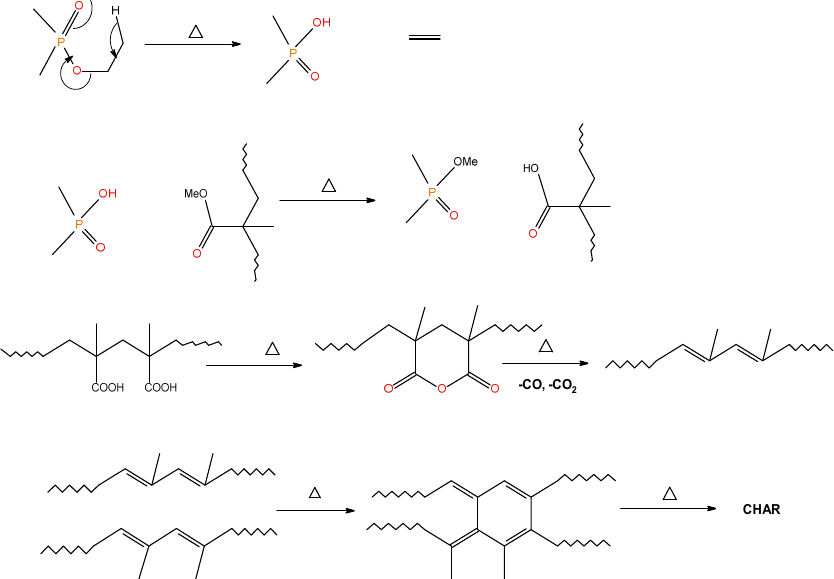
Figure 5. A schematic representation of the formation of char residues in the PMMA-based polymers upon flaming combustion [19].